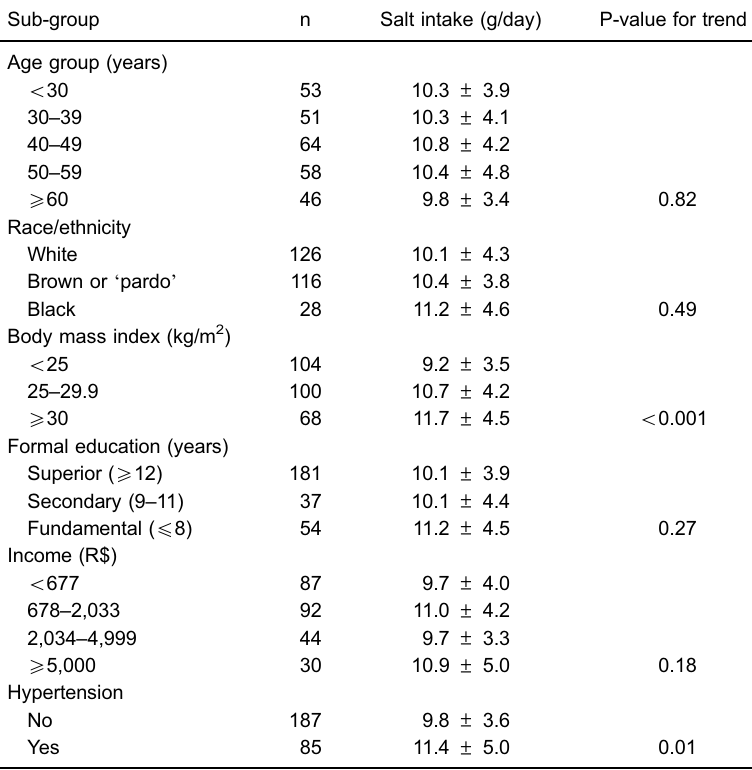
Table 2. Daily salt intake strati fi ed by sub-groups according to demographic, socioeco- nomic, and health characteristics.